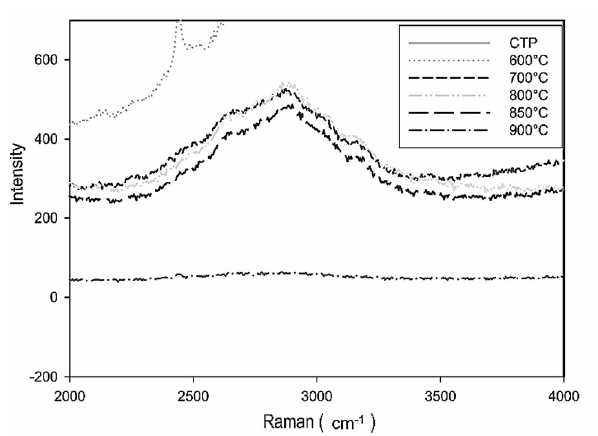
Fig. 7 2D and D ? G bands obtained from RS results for a sample of solids obtained at different working temperatures